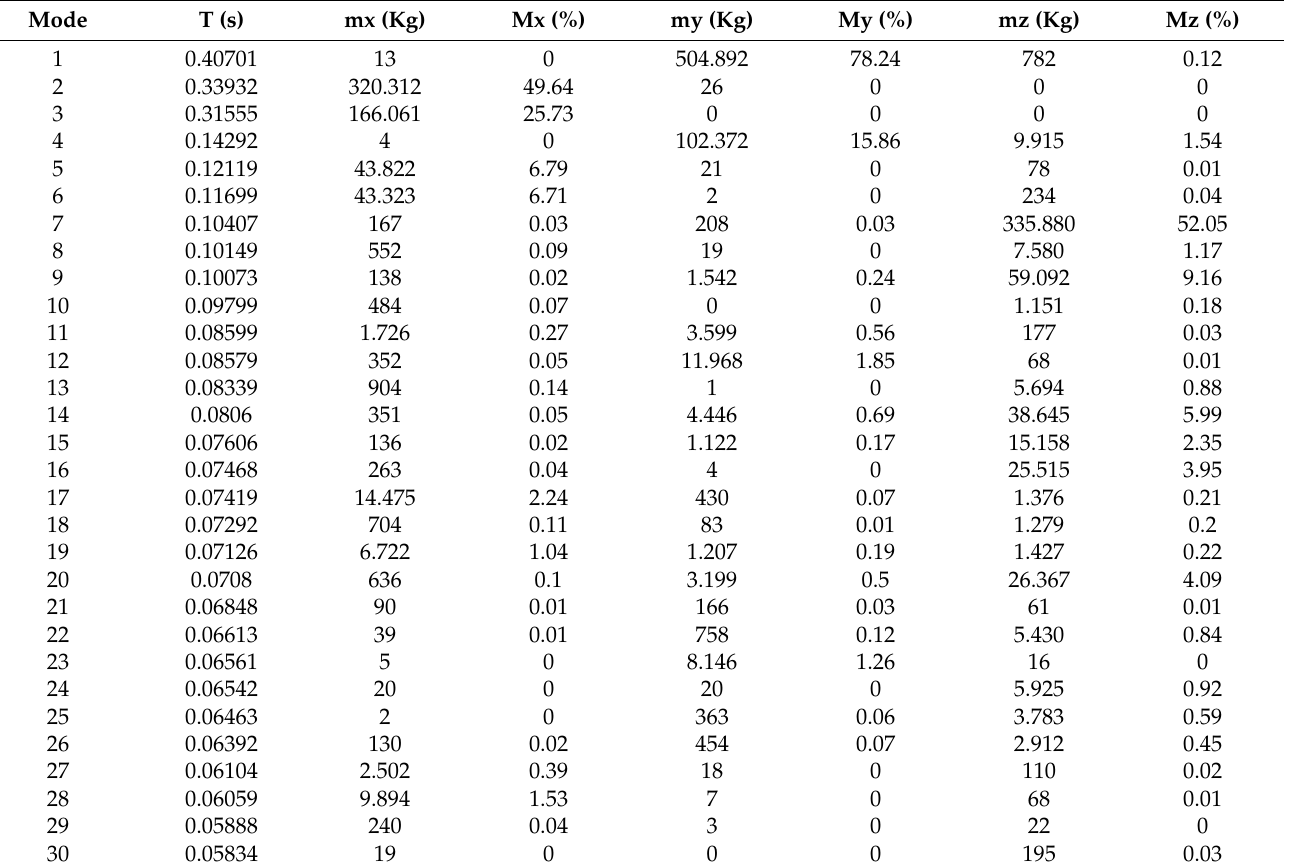
Table 2. Dynamic analysis results on the bare